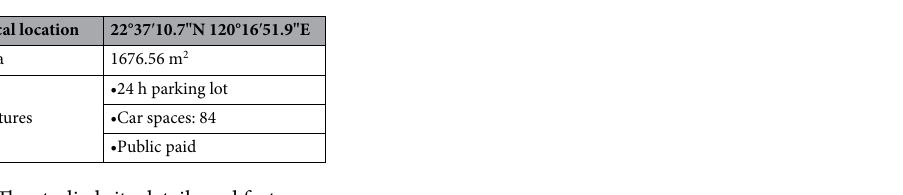
Table 1. The studied site details and features.